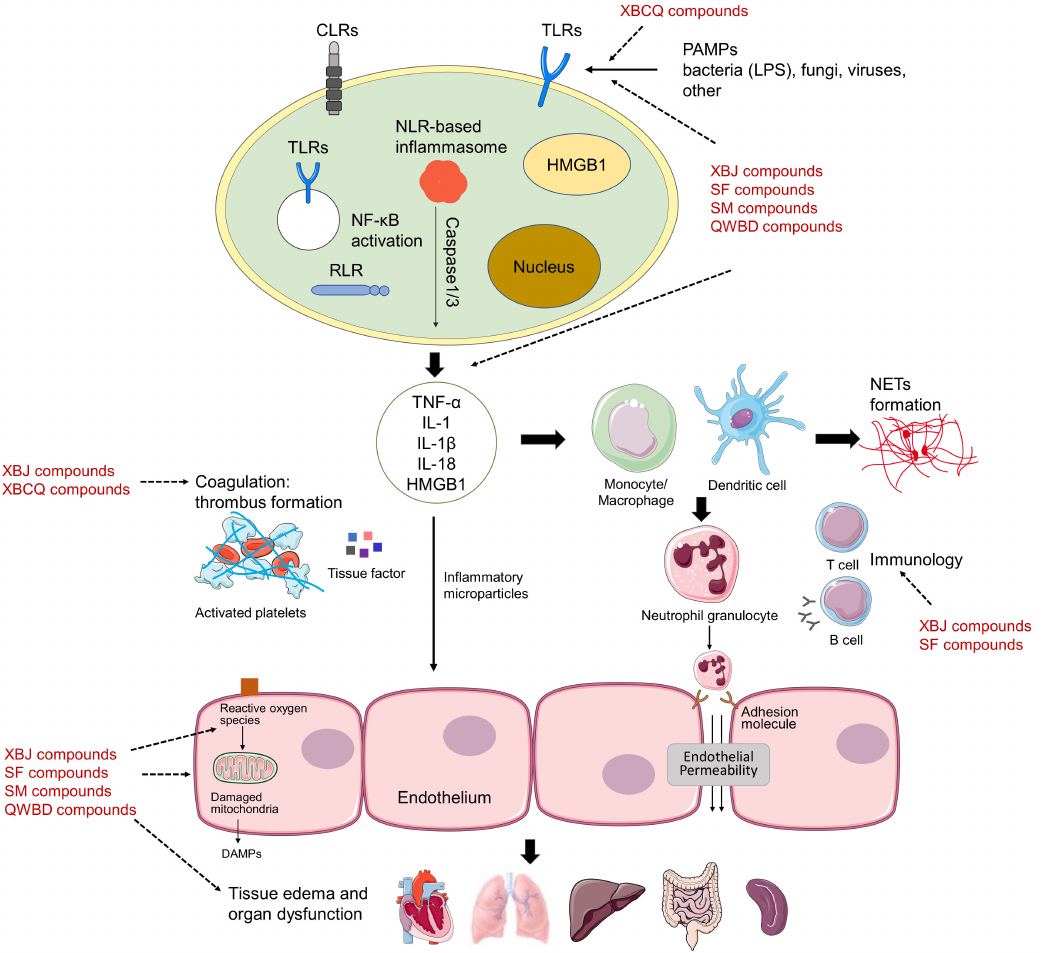
Figure 2. Potential mechanism of antisepsis actions of the five CHM based on pathophysiologic processes involved in sepsis. The dash line arrows indicate proposed action targets or signaling pathways that the five CHM probably involve; the